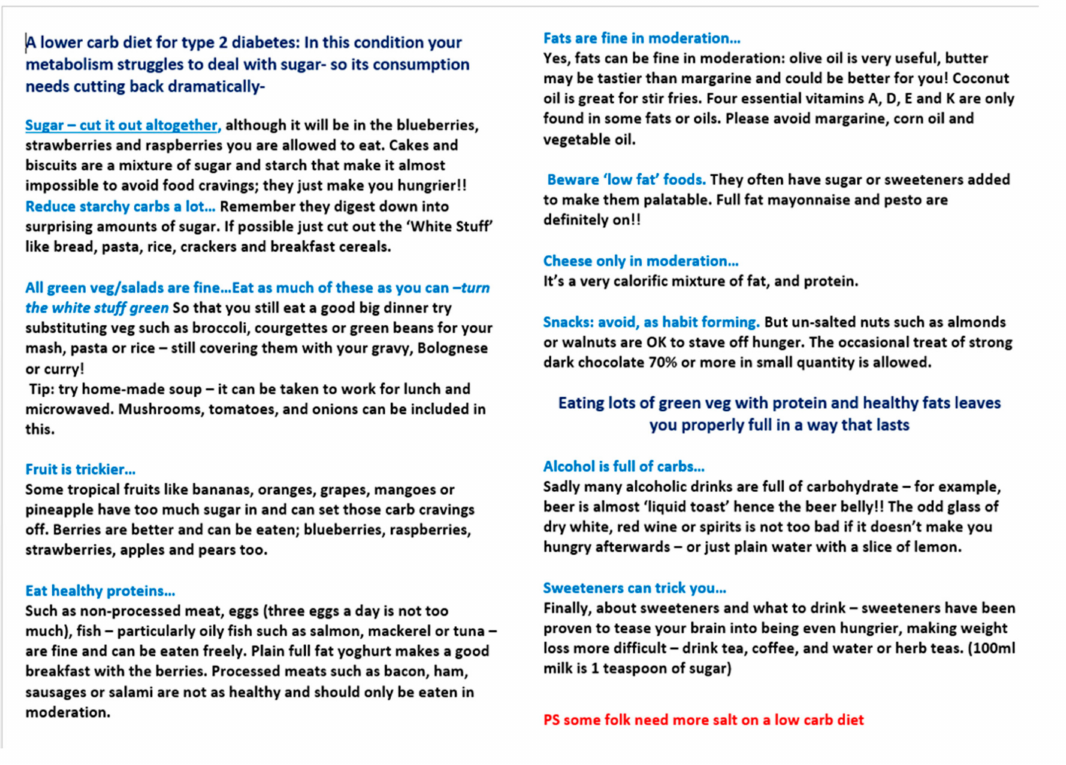
Figure 1. The standard Norwood Surgery low carb diet